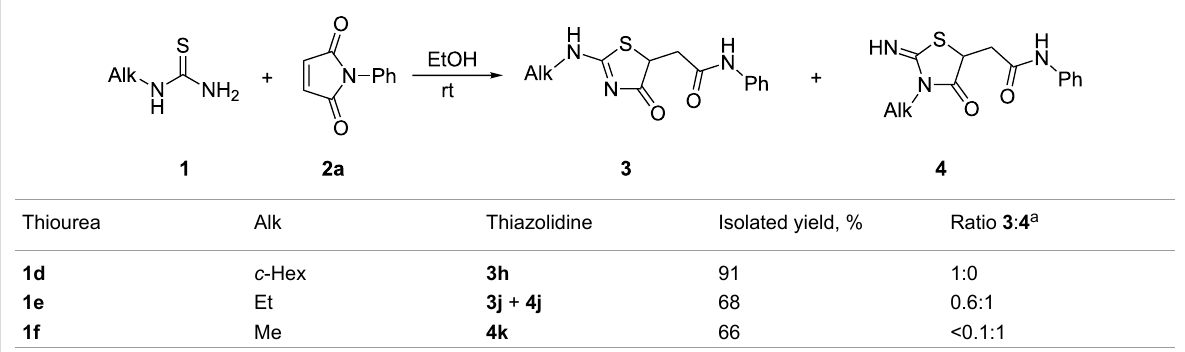
Table 2: Reaction of monoalkylthioureas 1d–f with N -phenylmaleimide ( 2a ) at room temperature .